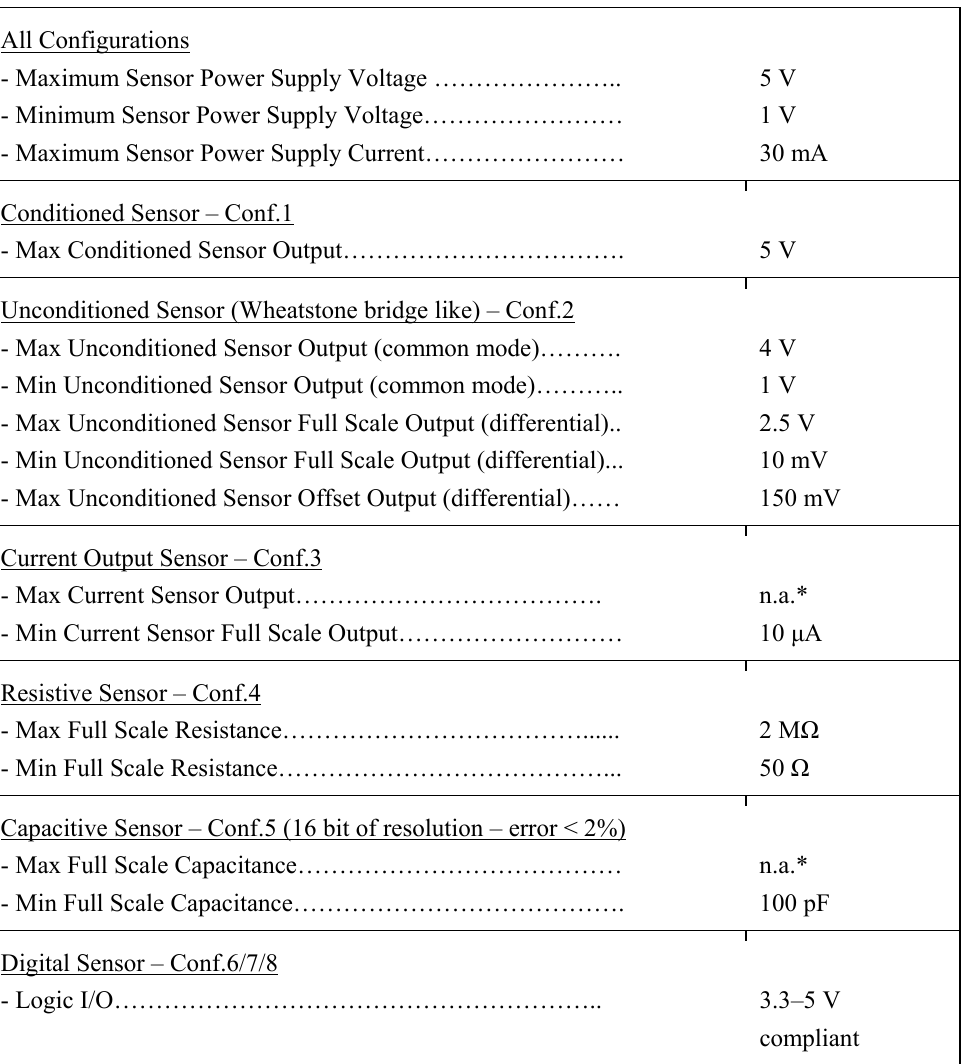
Table 2. Detailed UISI electrical power